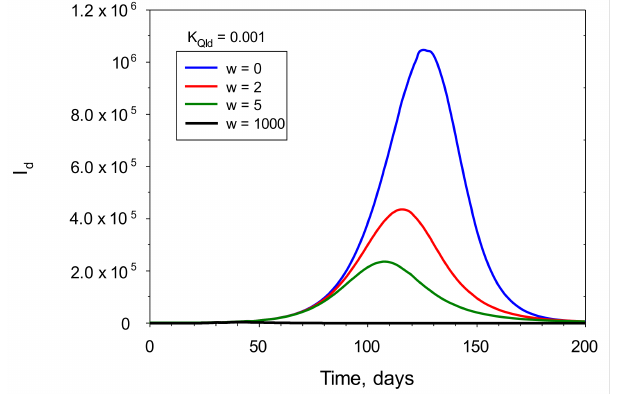
Figure 7. Calculated plots of diagnosed, infected ( I d ) for increasing values of the mean number of isolated individuals per one confirmed infected ( w ). The simulations were performed by inserting the values of the parameters displayed in Table 1, plus the values of w and K QId that appear in the legend, into the model’s equations. K QId was fixed at